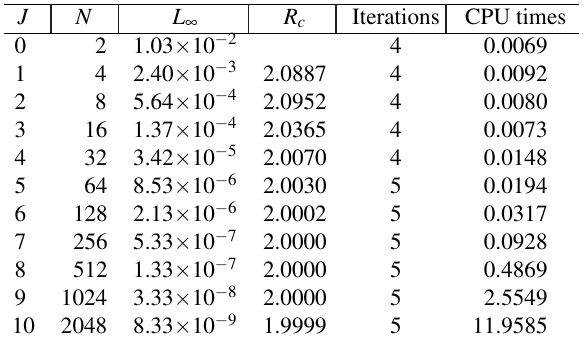
Table 2. L ∞ of Test Problem 3 at different numbers of collocation points